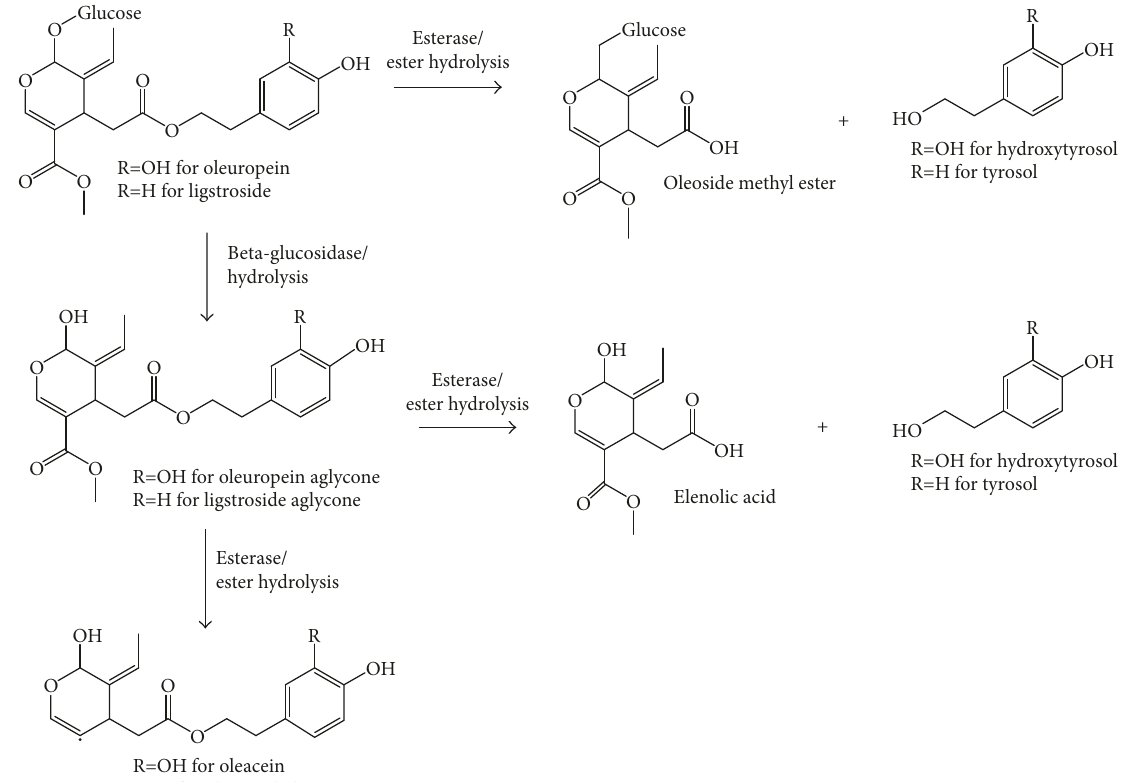
Figure 2: Olive secoiridoids and their hydrolysis